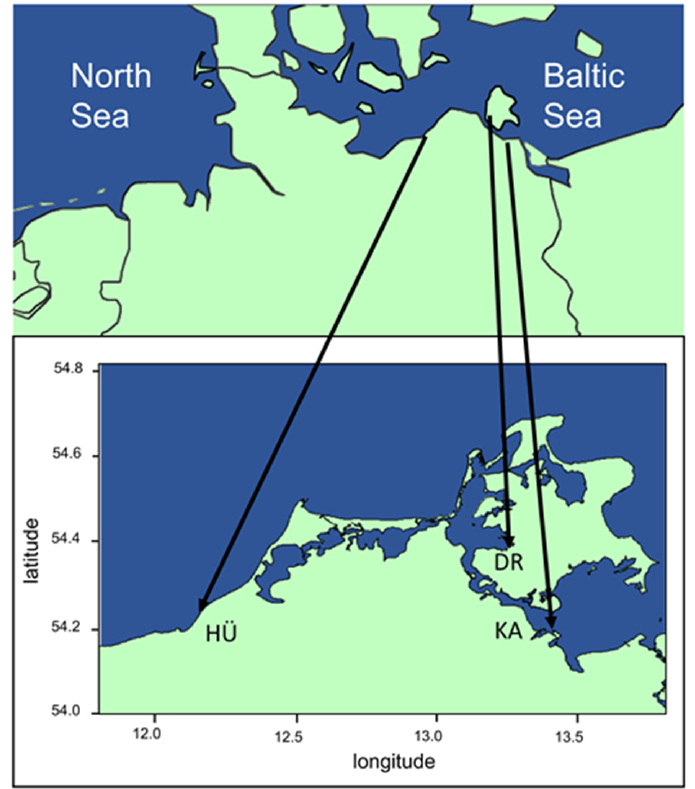
Figure 1. Map of northern Germany showing the three sampling sites HÜ (Hütelmoor), DR (Dram- mendorf) and KA (Karrendorf) next to the southern Baltic Sea.